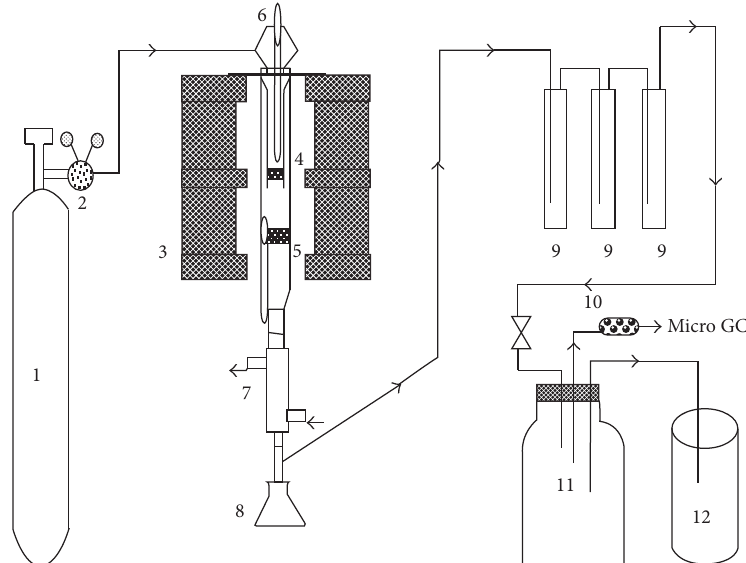
Figure 1: A schematic figure of the experimental apparatus. ( 1 ) nitrogen cylinder, ( 2 ) flow controller, ( 3 ) electric ring furnace, ( 4 ) coal layer, ( 5 ) catalyst layer, ( 6 ) thermocouple, ( 7 ) condenser, (8) conical flask, (9) acetone traps, (10) silica gel, (11) gas collector, and (12) measuring cylinder.